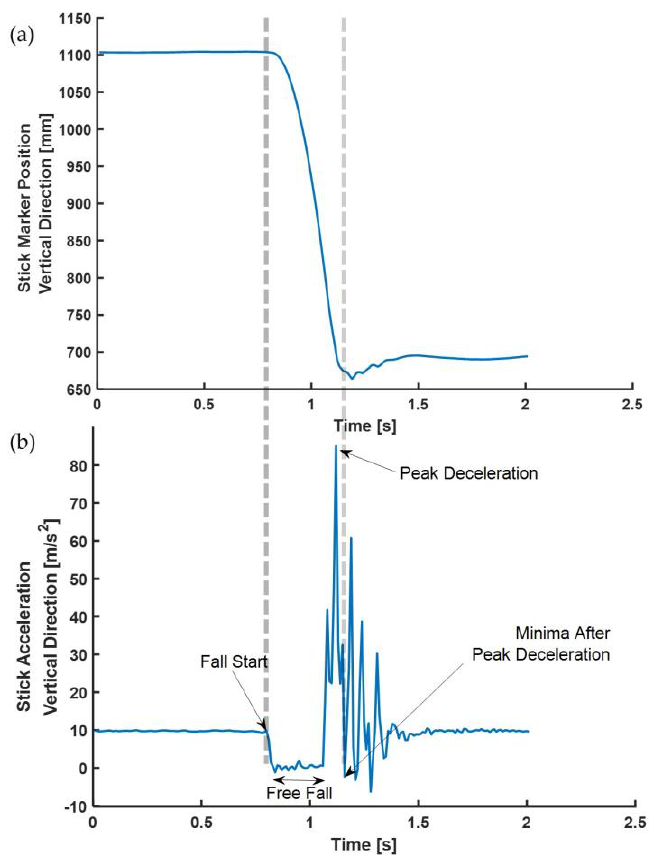
Figure 4. ( a ) Vertical marker position during a stick fall, ( b ) Vertical acceleration trajectory during a stick fall.